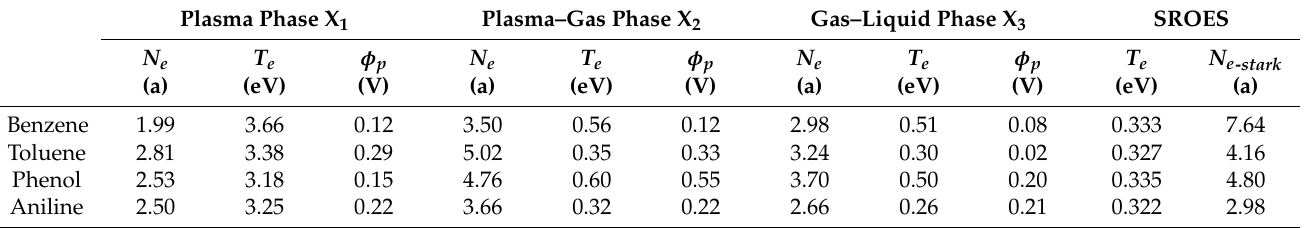
Table 1. Electron density N e , electron temperature T e , and plasma potential φ p of different phases of benzene, toluene, phenol, and aniline from Langmuir probe system and plasma blackbody tempera- ture T b , and electron density N e -stark of Stark broadening from SROES system. Plasma Phase X